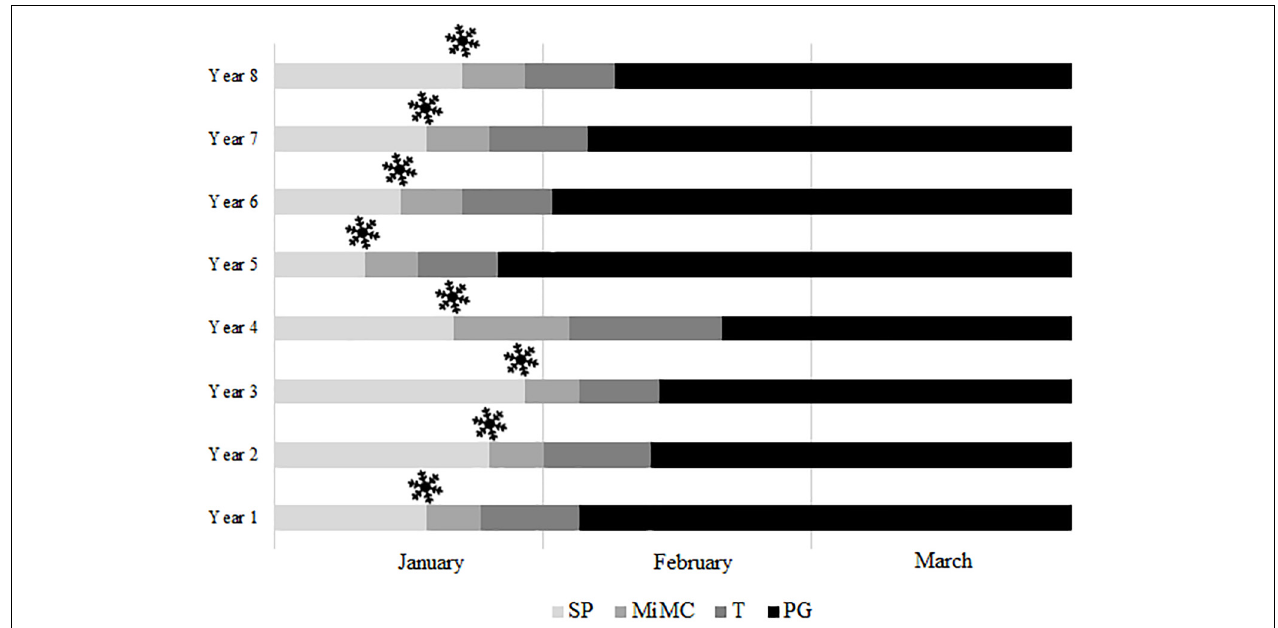
FIGURE 6 | Anther development from endodormancy to flowering in the apricot cultivar “Pandora” over eight years. SP, sporogenous tissue; MiMC, microspore mother cells; T, tetrads; PG, pollen grains; (cid:2) , estimation of endodormancy breaking